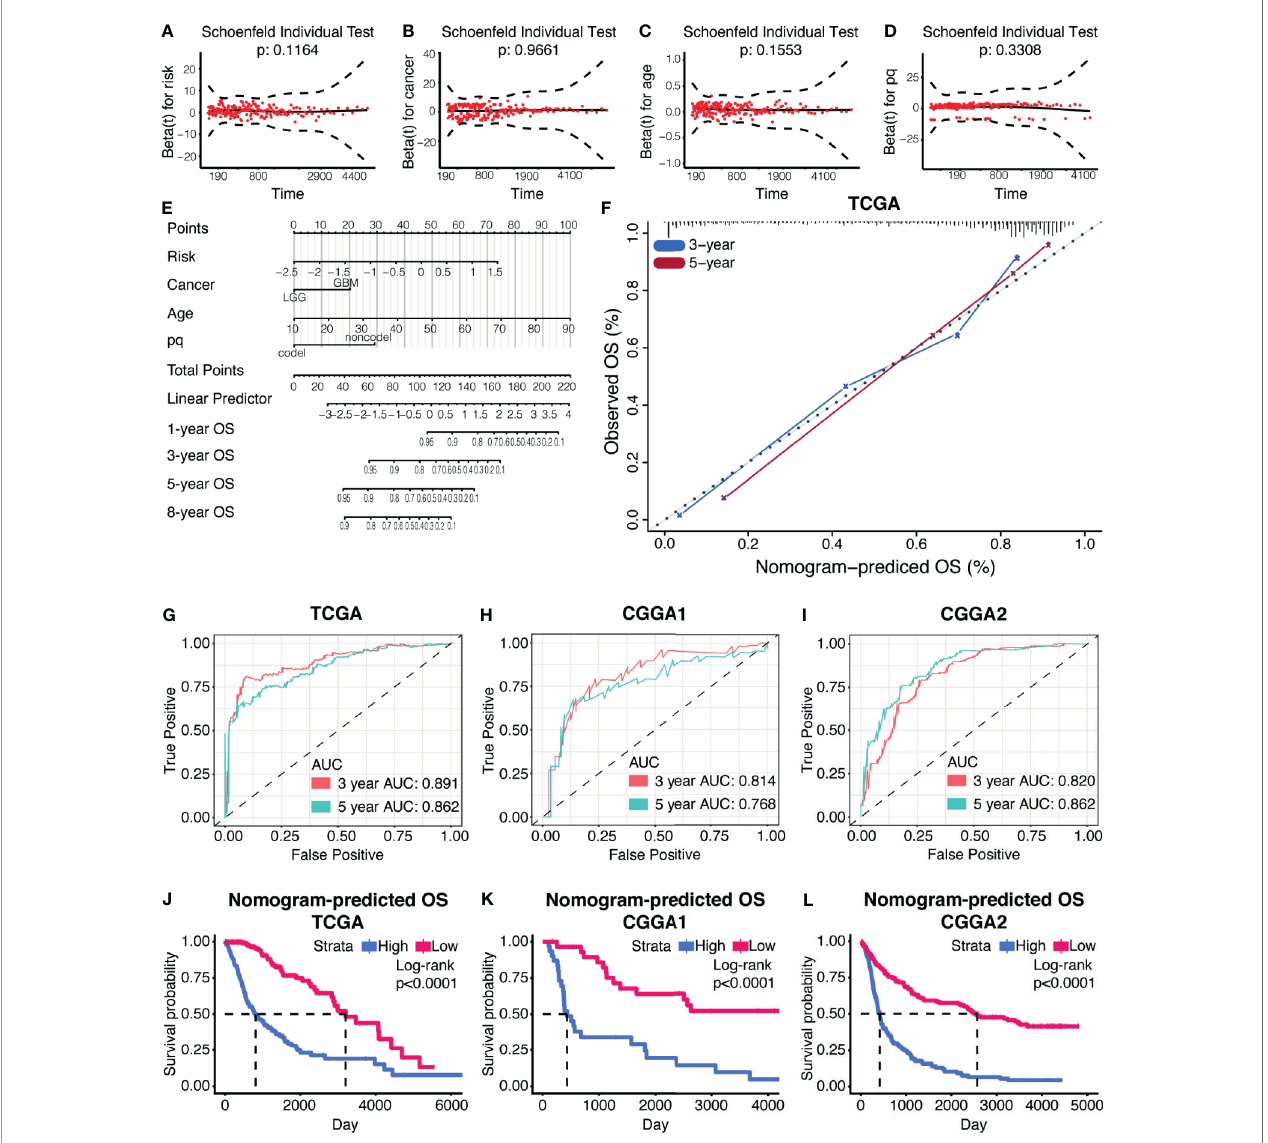
FIGURE 8 | Prognostic nomogram based on the risk model. (A – D) The Schoenfeld test of the factors involved in the construction of the nomogram. (E) The nomogram based on the risk model. (F) The calibration curve of 3-year and 5-year OS based on the nomogram. ROC curves and AUC values from the nomogram of 3-year and 5-year OS, in TCGA datasets (G) , CGGA1 datasets (H) , and CGGA2 datasets (I) . (J – L) Survival analysis based on the nomogram in TCGA datasets (J) , CGGA1 datasets (K) , and CGGA2 datasets (L)